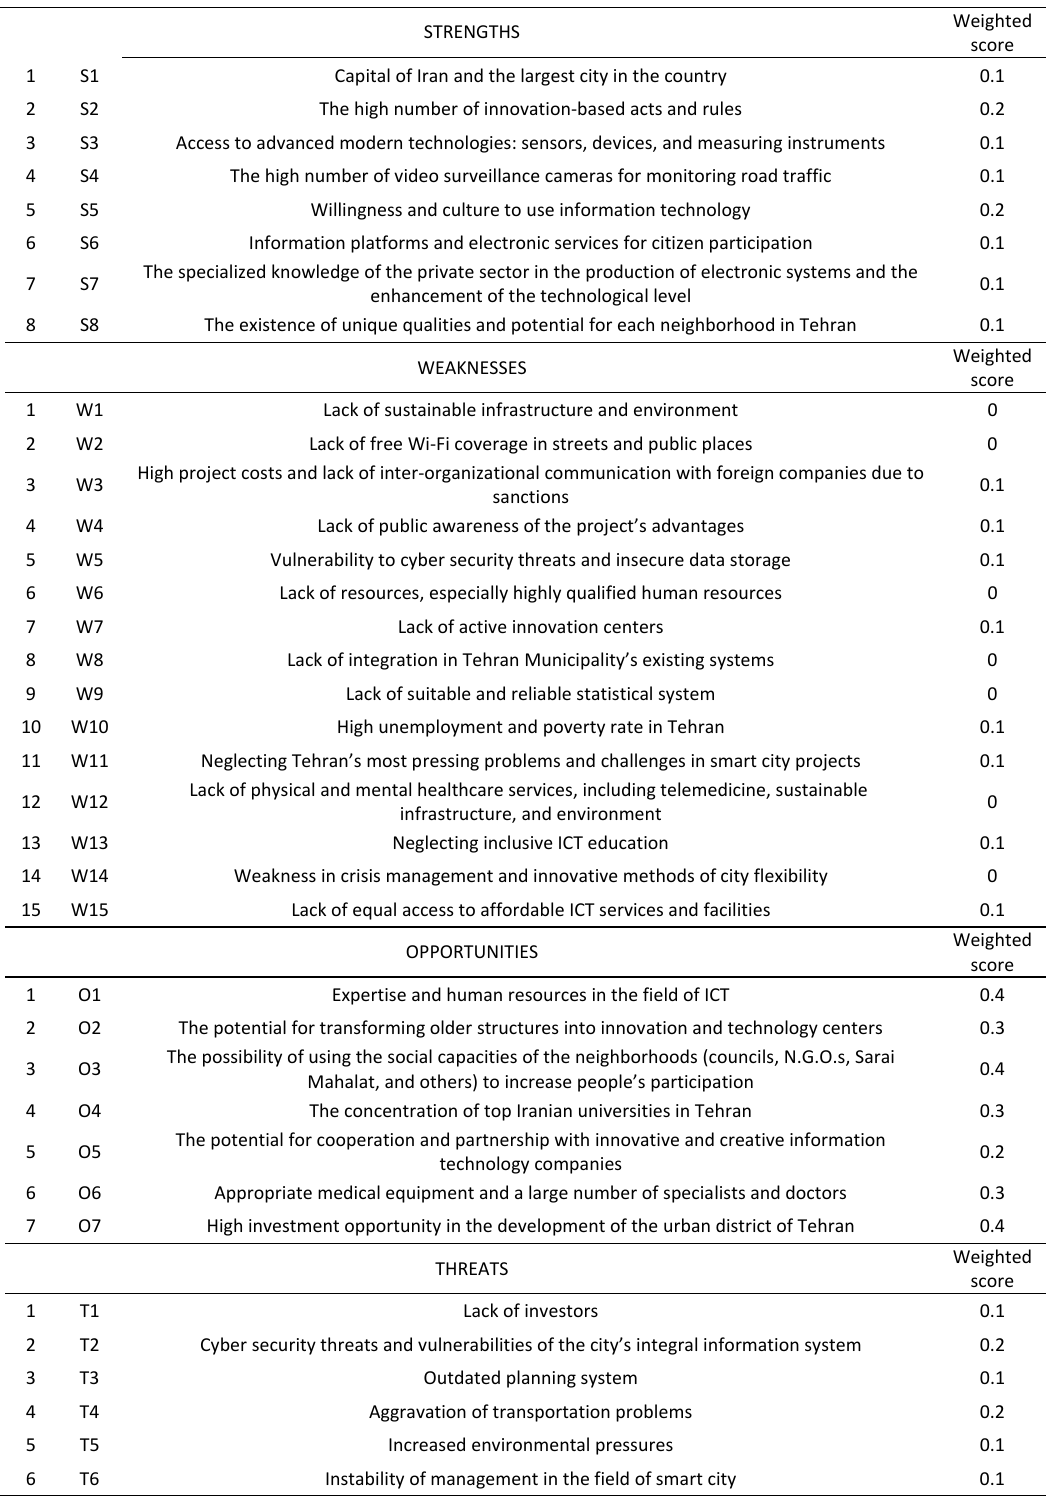
Table 5: SWOT analysis in the smart city of Tehran based on the hierarchy of needs